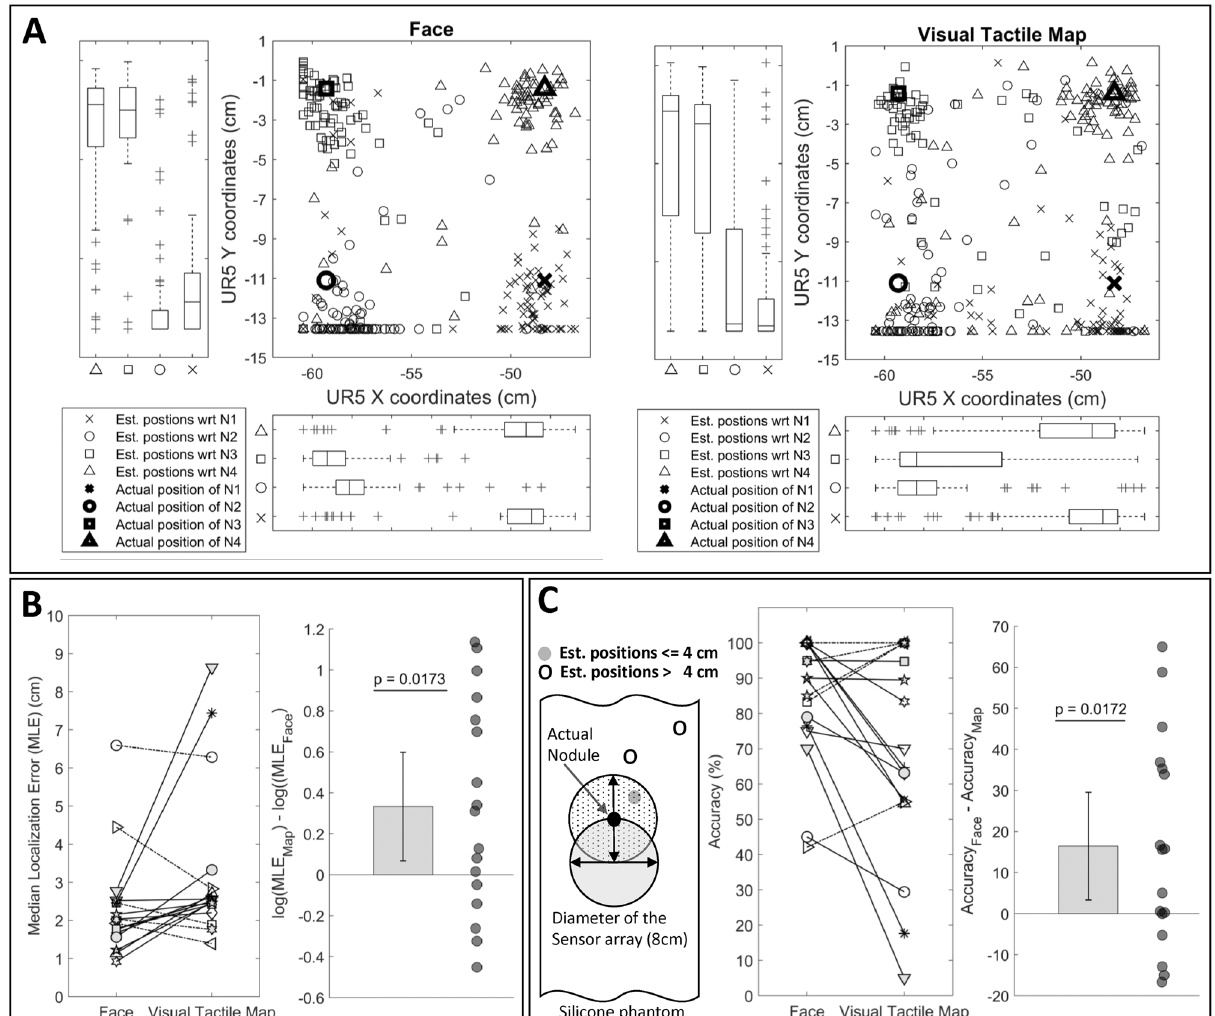
Figure 5. Estimated nodule positions, localization error and accuracy results for all participants (A) Estimated nodule positions by all participants during all successful trials (i.e., trials where the participant estimated the nodule position before 90 s) for each experiment. Box plots show the distributions of estimated nodule positions relative to actual nodule positions. (B) Left shows the paired plot for distribution of median localization error of successful trials of all participants. Each symbol represents an individual participant. (B) Right shows the log transformed distribution of the differences between the median localization error together with all data presented as a scatter plot. Thin black line represents the 95-confidence interval of the estimated mean difference. The p-value of the one-sample t-test ( t 16 = 2.6541, p = 0.0173 ) is shown above the plot. (C) Left we classified estimated nodule positions as accurate if they fell within the radius of 4 cm (as illustrates in the sketch) given that the diameter of the tactile sensor array was 8 cm . Based on this notion. (C) Center shows the paired plot of accuracy for all participants between the two feedback methods. Each symbol represents an individual participant. (C) Right shows the difference of accuracy between face mediated approach and visual tactile map feedback together with all data presented as a scatter plot. Thin black line represents the 95-confidence interval. The p-value of the one-sample t-test ( t 16 = 2.6565, p = 0.0172 ) is shown above the plot. MATLAB 2020a (https:// www. mathw orks. com) is used to generate the